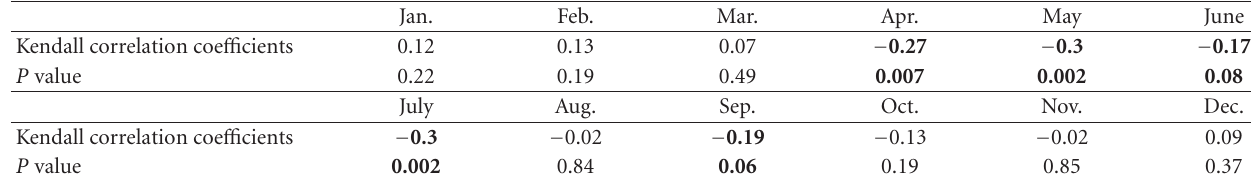
Table 3: Correlation analysis for monthly temperature and rainfall from 1961 to 2010.